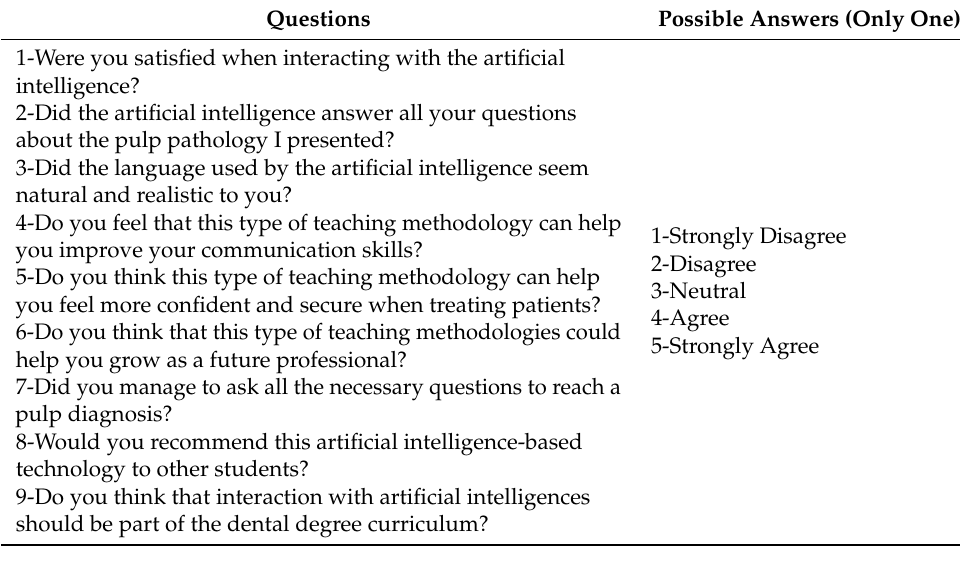
Table 3. Questions of the questionnaire with possible answers.